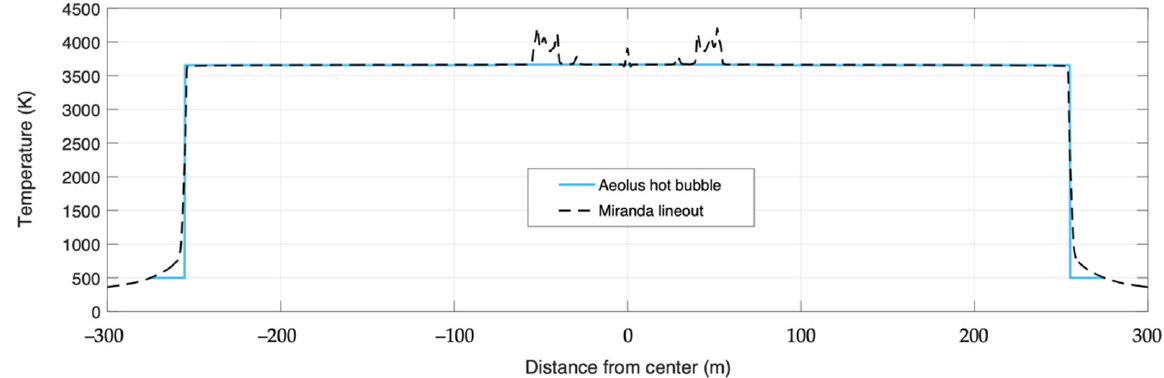
Figure 11. Temperature profile of the initial hot Dixie bubble used in Aeolus (blue solid line) based on a Miranda prediction (black dashed line).